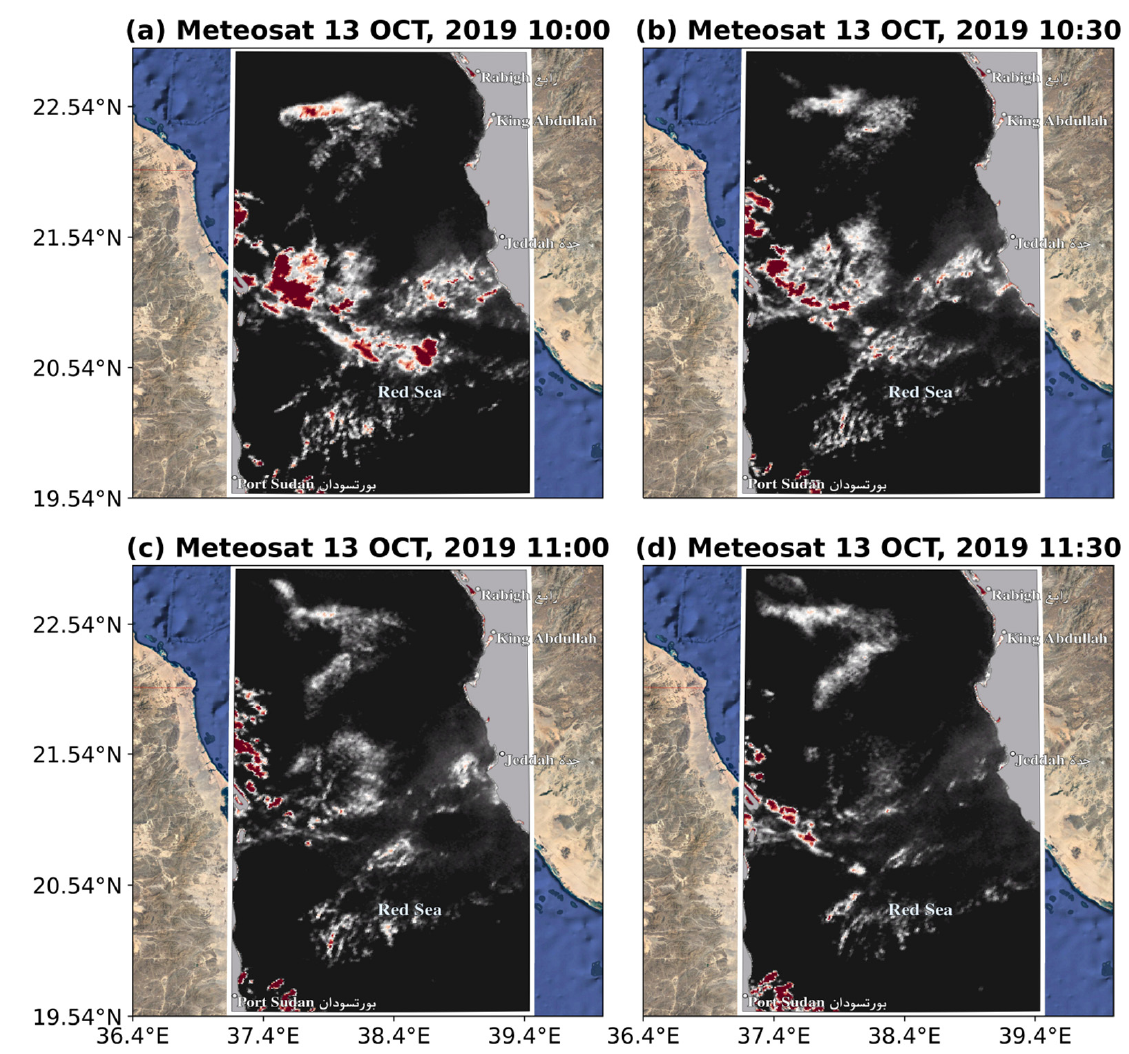
Figure 9. Meteosat HRV channel Level 1.5 images at 10:00 UTC, 10:30 UTC, 11:00 UTC, and 11:30 UTC on 13 October 2019.